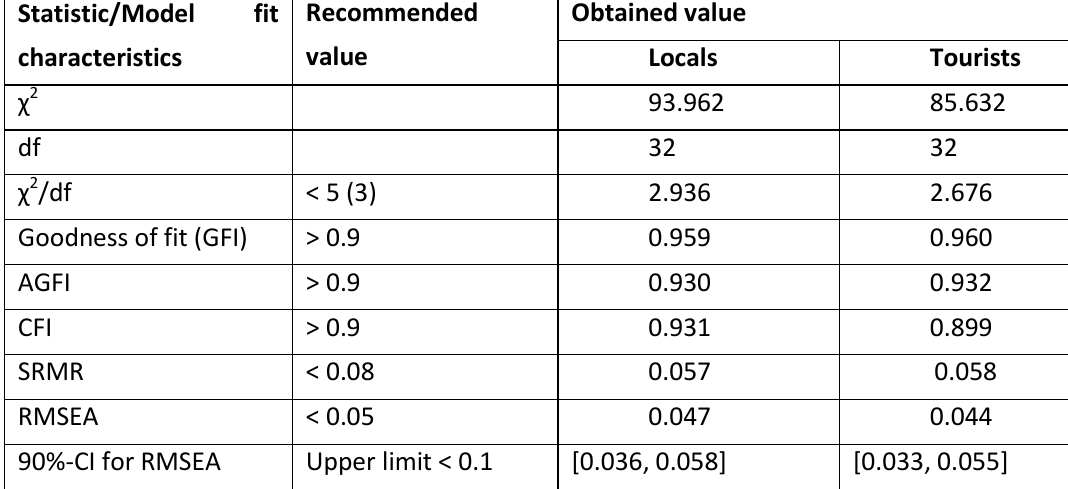
Table 4: As goodness of fit measures t he relative χ2 (χ2/df, df denotes the degrees of freedom), the goodness of fit (GFI), the adjusted goodness of fit (AGFI), the comparative fit index (CFI), the standardized root mean squared error (SRMR), the root mean squared error of approximation (RMSEA) and its 90%-confidence interval were computed. Obtained model fit indices with recommended values (e.g., Byrne, 2006) are given for the locals and for the